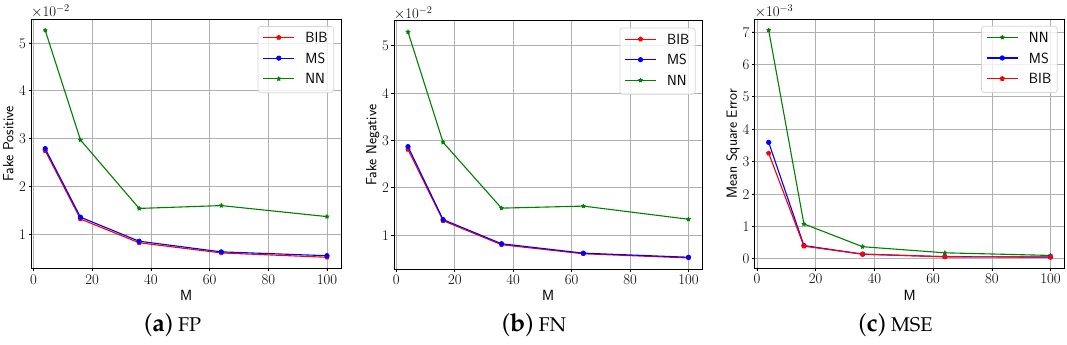
Figure 13. The average FP, FN, and MSE versus the grid numbers M for the three mentioned algorithms in the artificially-constructed environment data